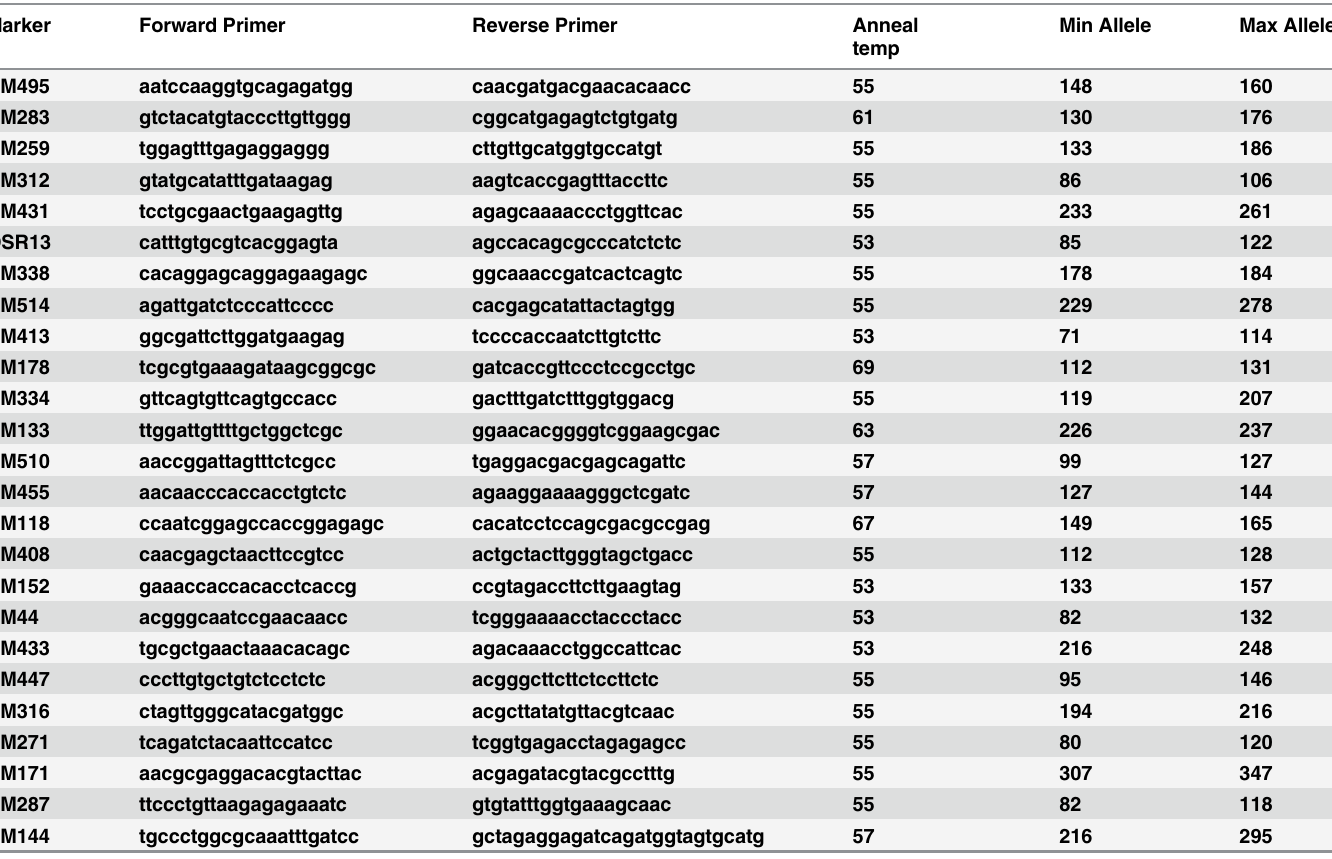
Table 2. List of information SSR primers used in this study.